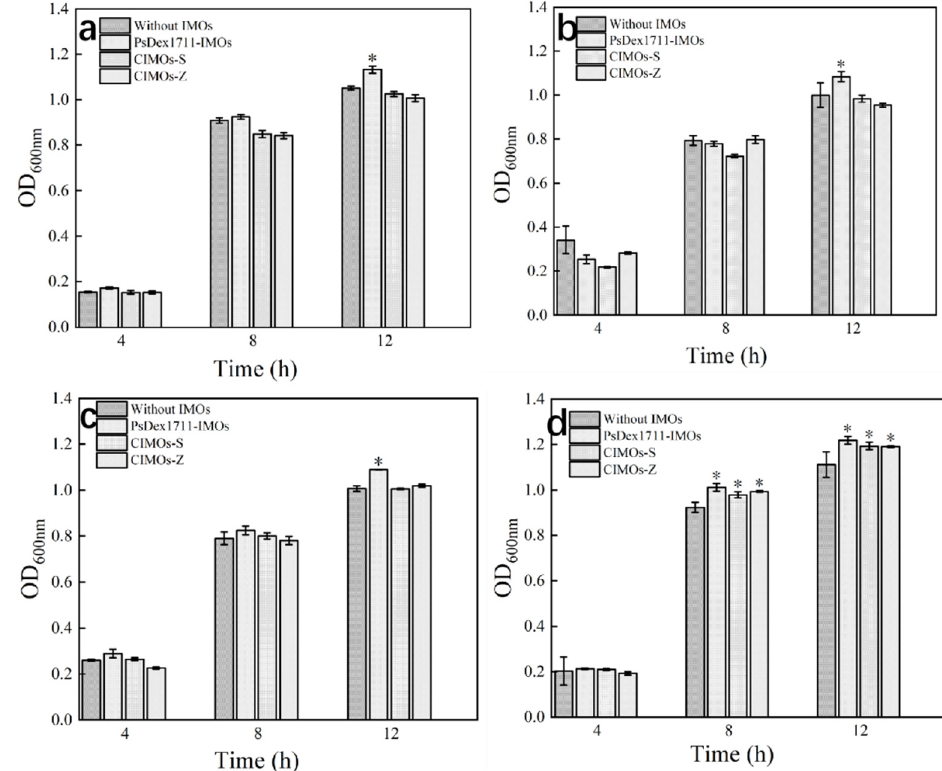
Figure 6. Effects of different isomaltose supplemental levels on the growth of the four probiotics: IMO supplemental levels were 0.5, 1, and 2.5 g/L, respectively; ( a ) Lactobacillus paracei , IMO was 1 g/L; ( b ) Bifidobacterium infantis , IMO was 2.5 g/L; ( c ) Lactobacillus reuteri , IMO was 1 g/L; ( d ) Bifidobacterium lactis , IMO was 1 g/L. *: The results were significantly different compared to the control group.